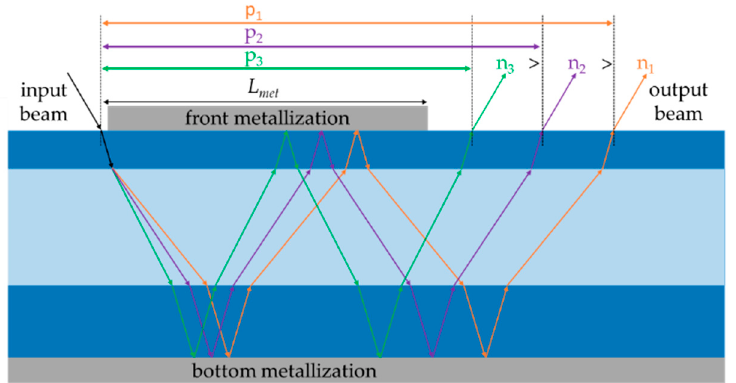
Figure 2. Schematic representation of the propagation of the light into the channel when different sample fluids with increasing RI are considered ( N = 2).